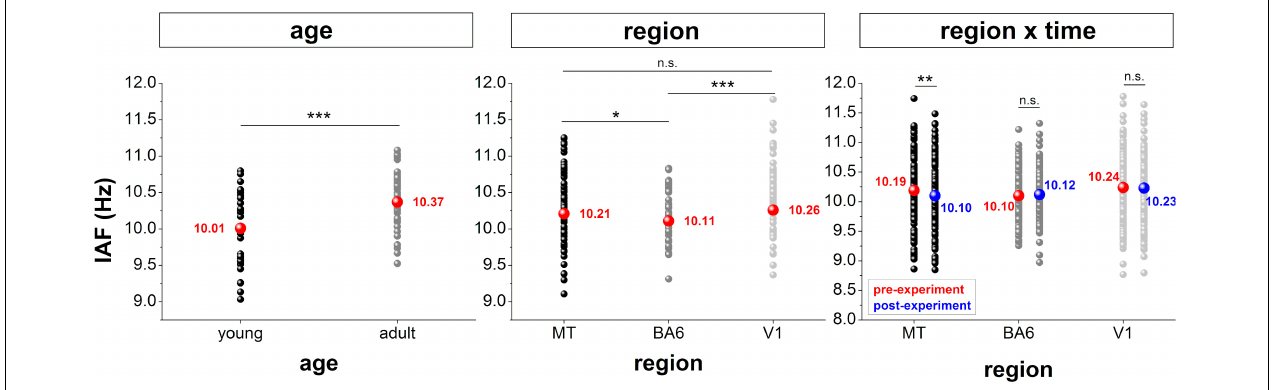
FIGURE 2 | Summary of control analyses results indicating the effects of age, cortical region, and time on IAF. Figures reflect the mean (colored dot) as well as the values for all participants included (black/gray dots). n.s. = not significant, * p < 0.05, ** p < 0.01, and *** p <